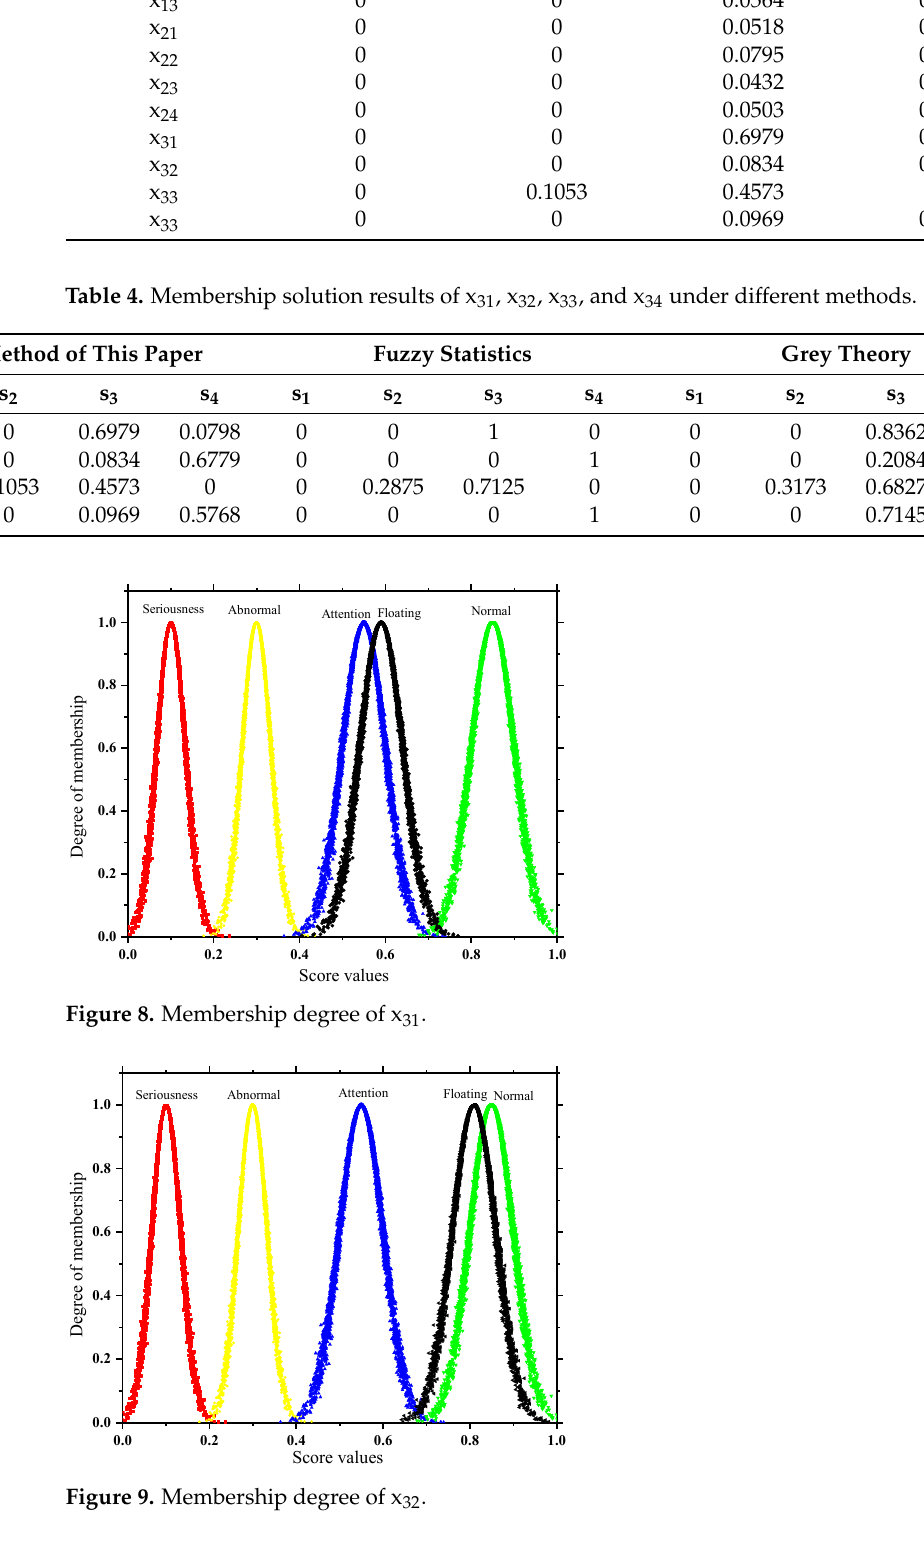
Figure 10. Membership degree of x 33. Figure 11. Membership degree of x 34. 5.3. Voltage Safety Level Judgement According to the relevant principles of D-S evidence theory, the relevant parameters of the factor layer indicators can be calculated by combining Equations (19) and (20), as shown in Table 5. Combined with Table 5, the target layer m ( B ) = {0, 0.0059, 0.1261, 0.6805,